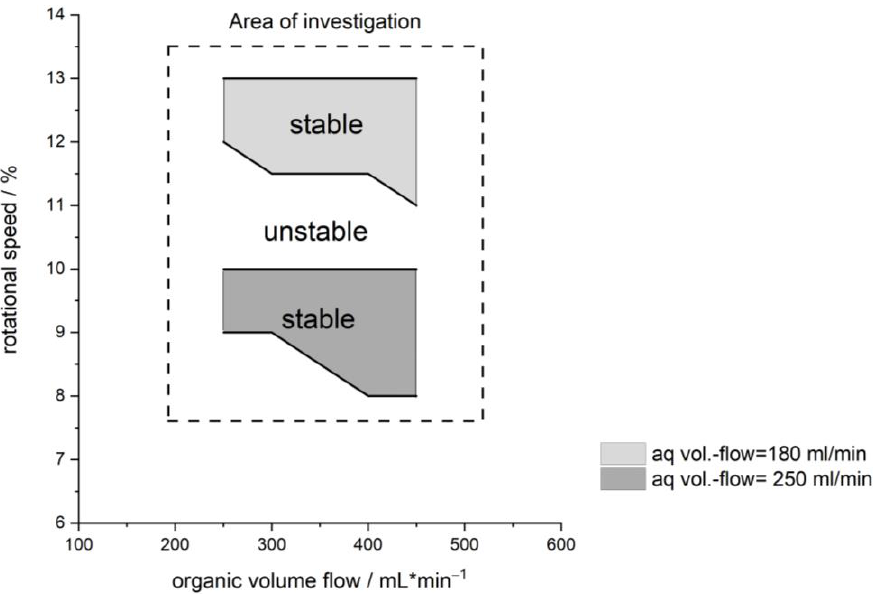
Figure 3. Operation window depending on the rotational speed of the rotor and the volume flow of the organic and aqueous phase.